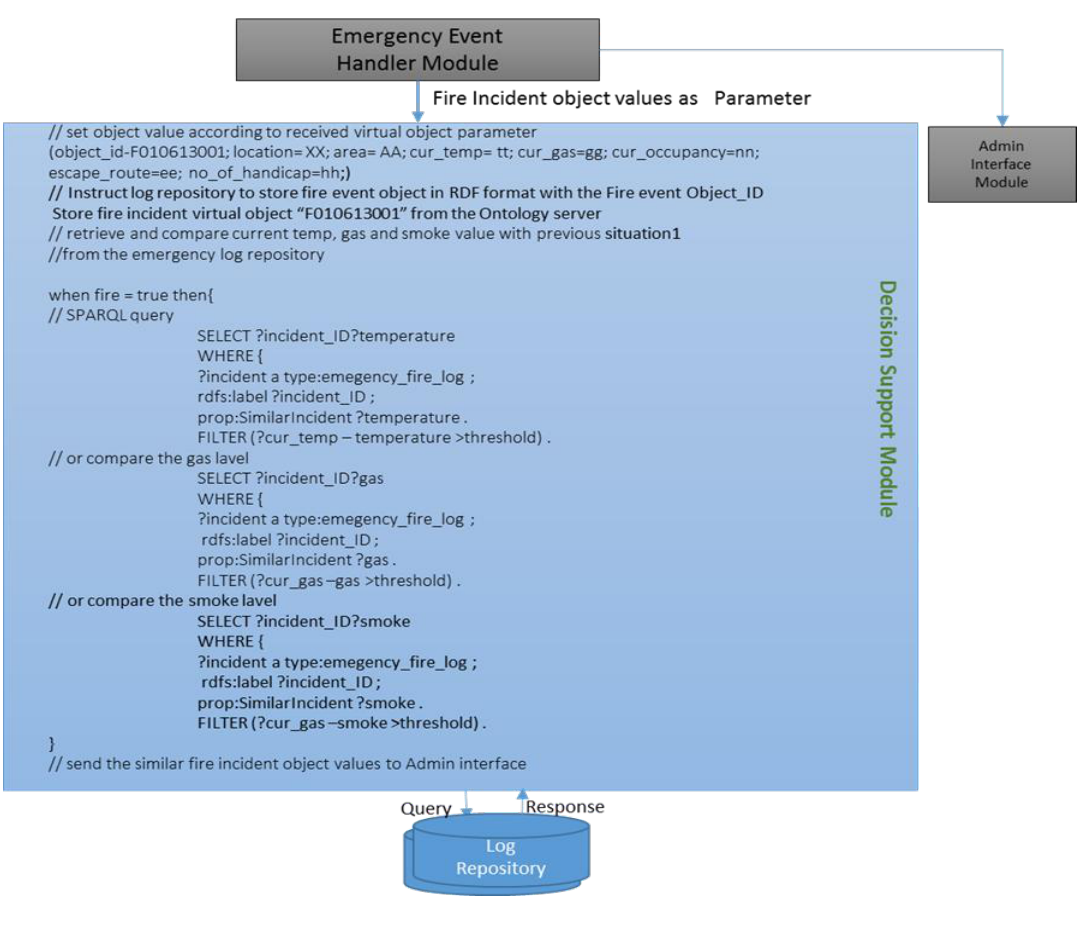
Figure 11. Searching similar incident in the log repository using the SPARQL